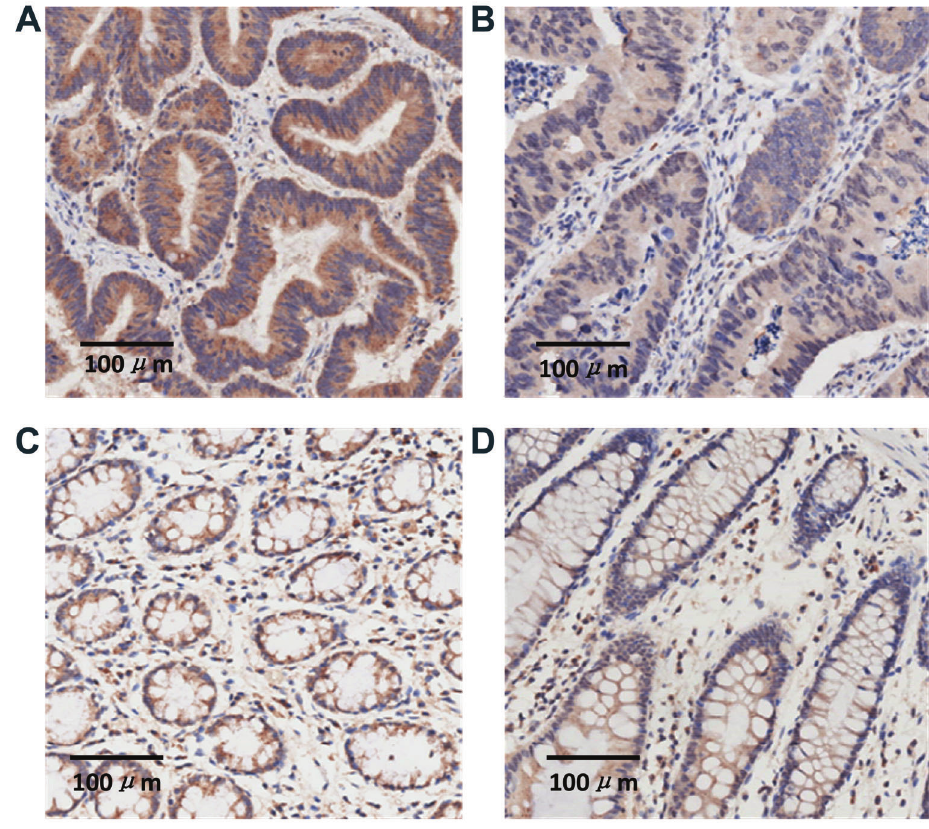
Figure 1. Representative immunohistochemistry images of CHD 9 expression in colorectal cancer tissues and para-carcinoma tissues: A , high CHD 9 expression in tumor; B , low CHD 9 expression in tumor; C , high CHD 9 expression in adjacent tissues; D , low CHD 9 expression in adjacent tissues (Magni fi cation: (cid:1) 200; bar: 100 m Table 2. Correlation analysis of CHD 9 expression and mismatch repair genes.